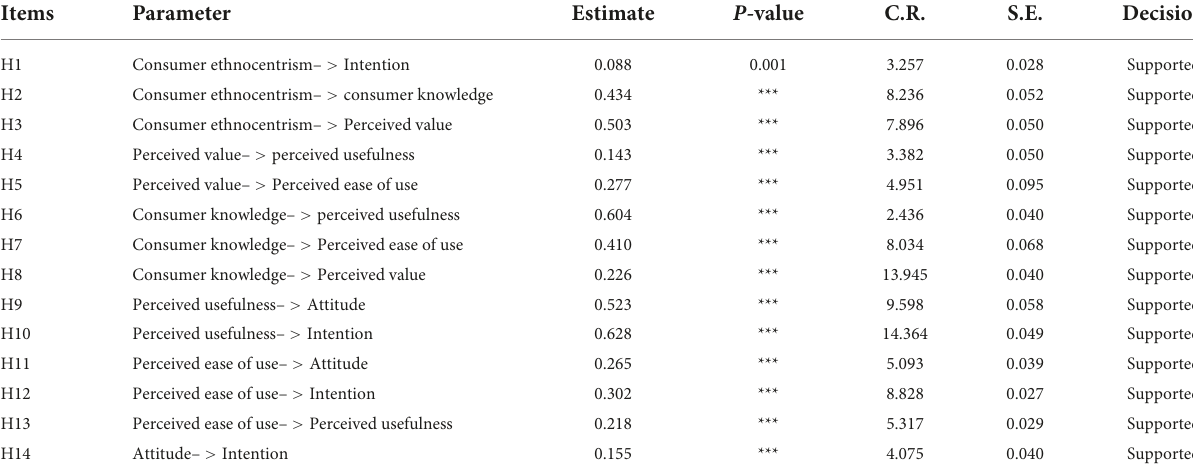
TABLE 5 Structural relationships and hypotheses